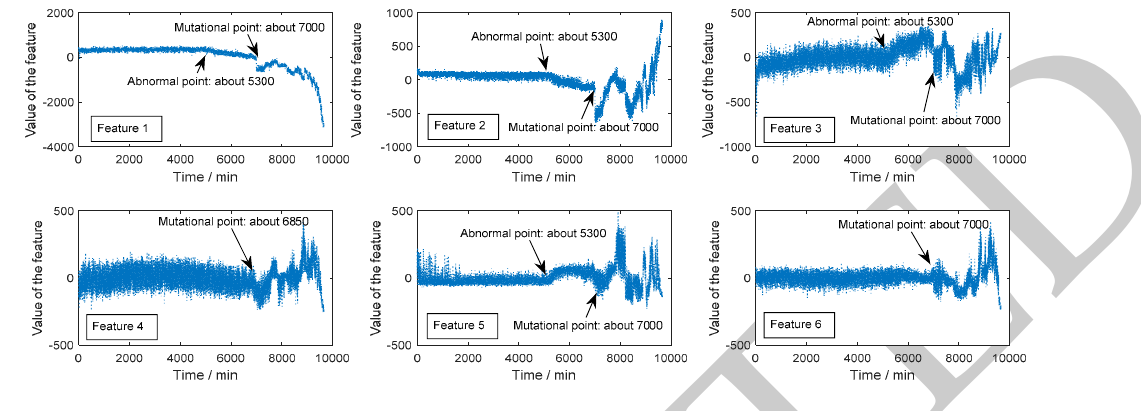
Figure 5. Eight of the features in original feature space.